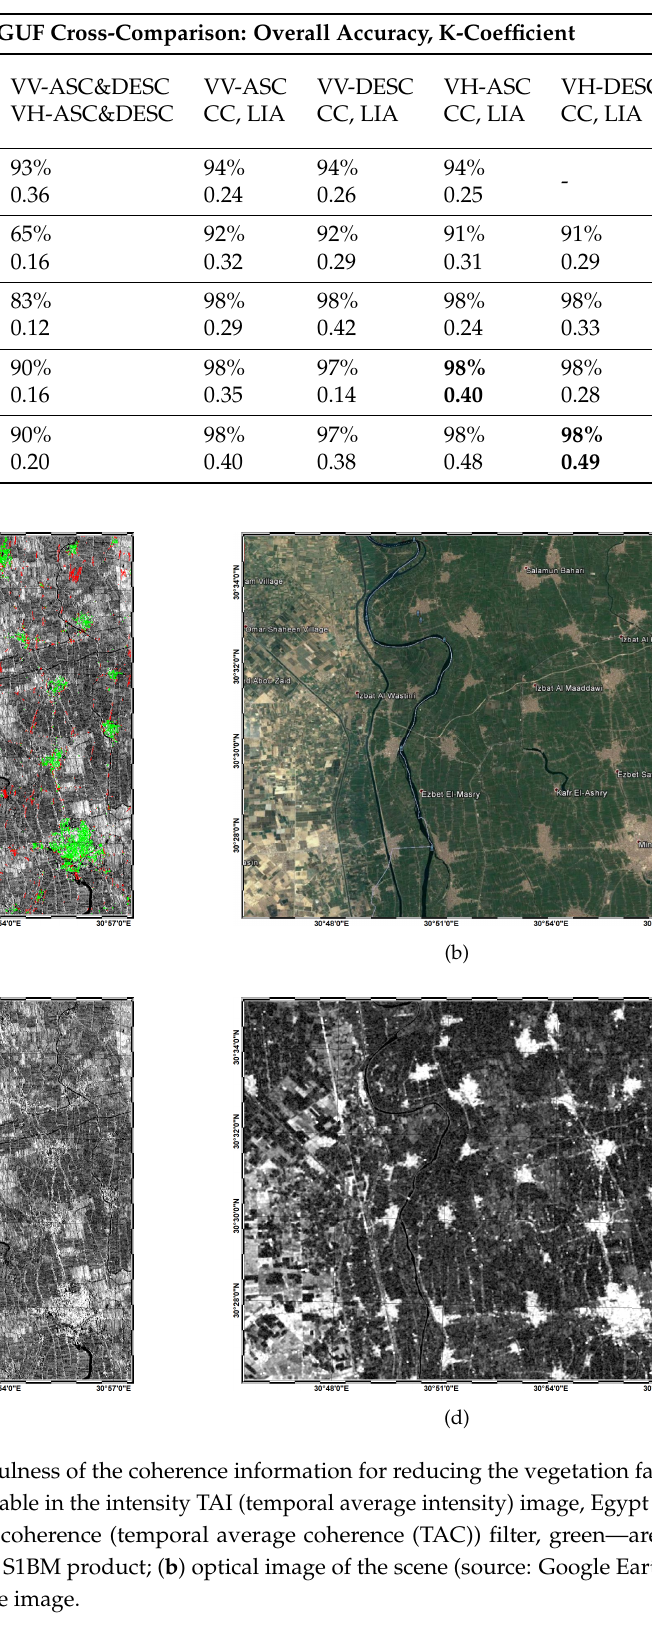
Table 2. Quantitative analysis for different combinations of the inputs and filters. CC—InSAR coherence filter, LIA—local incidence angle filter (best performances are highlighted in bold font).